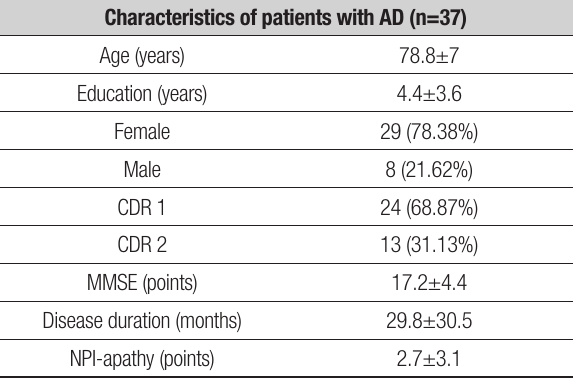
Table 1. Clinical and socio-demographic characteristics of study partici- pants with AD (n=37). Means and standard deviations of the following vari- ables: age, education, gender, stage of disease, Mini-Mental State Examina- tion, disease duration and average score on the Neuropsychiatric Inventory. Characteristics of patients with AD (n=37)